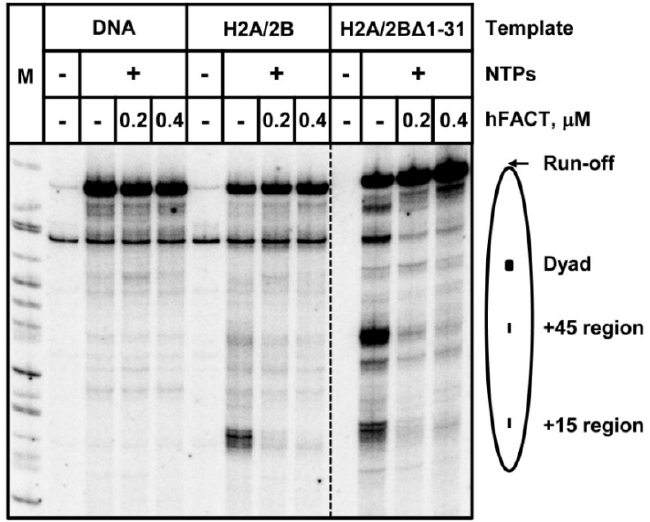
Figure 5. Deletion of H2B N-tail is not sufficient to inhibit FACT-facilitated transcription in vitro. In fact, 603 DNA or nucleosomes, which contained H2A/H2B or H2A/H2B ∆ 1-31 dimers, were transcribed by Pol II at 150 mM KCl in the presence or absence of human FACT protein complex. FACT strongly facilitates Pol II transcription through a nucleosome in vitro. This activity of FACT is not affected by the deletion of the H2B tail.